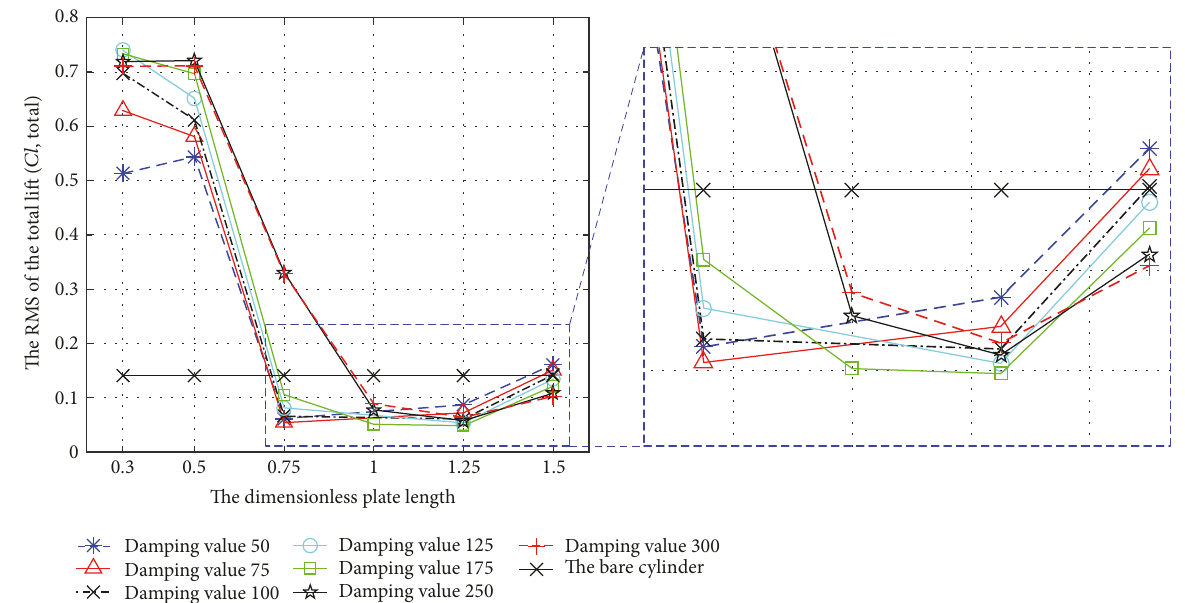
Figure 12: The variation of the total lift coefficient (RMS) with the changing of the dimensionless plate